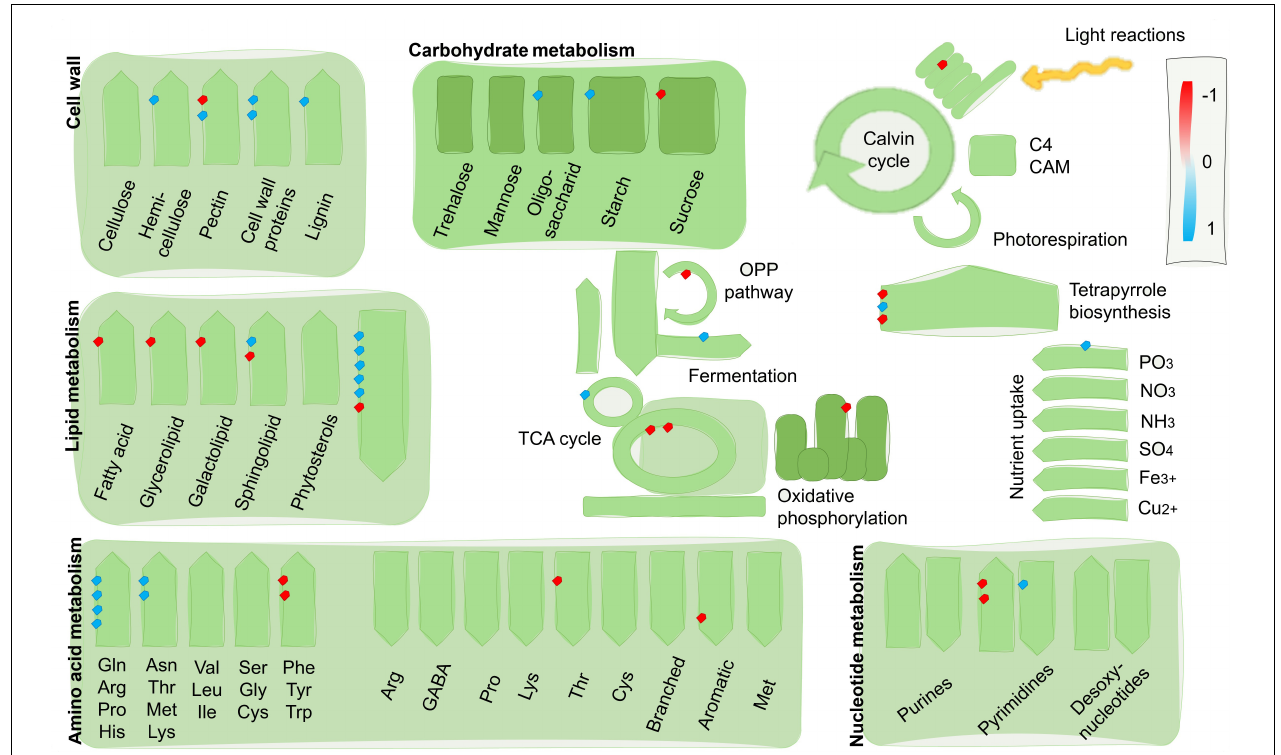
FIGURE 4 | Distribution of DEGs between resistant and susceptible inbred bulks visualized with MapMan. Genes up and down-expressed in resistant vs. susceptible inbred bulks are in blue and red, respectively.